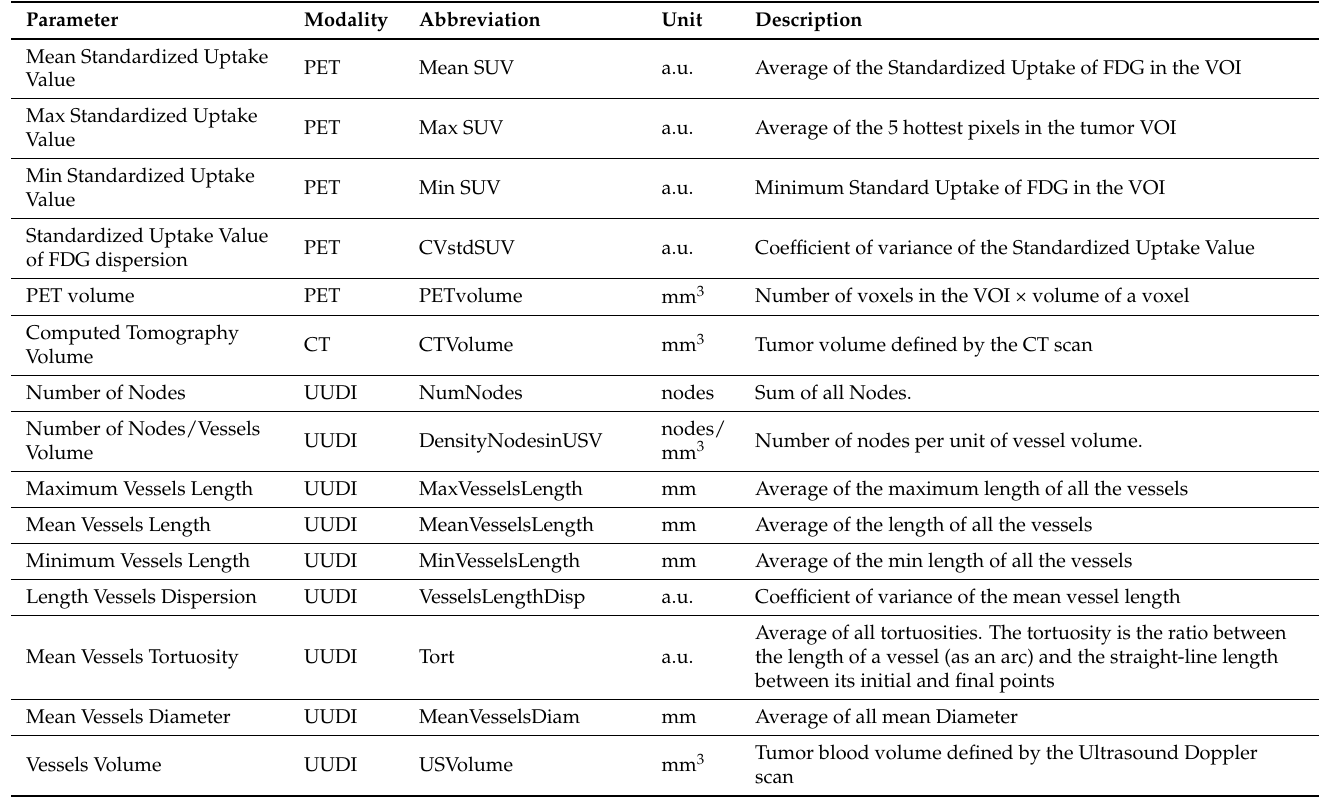
Table 1. PET/CT/UUDI extracted